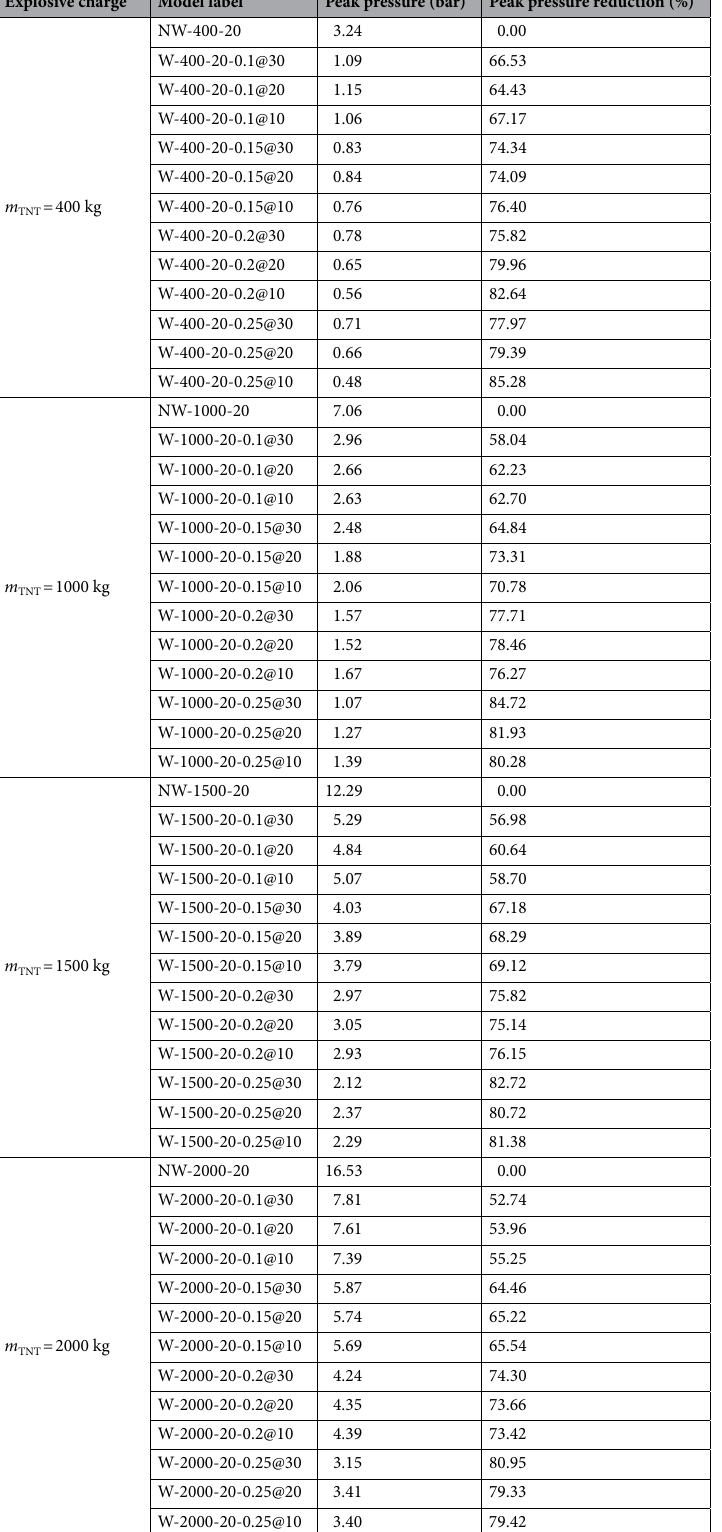
Table 8. Details of peak pressures for different